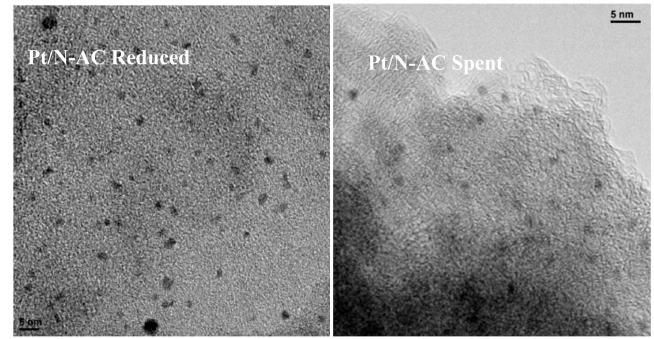
Figure 11. TEM of reduced and spent Pt / N-AC